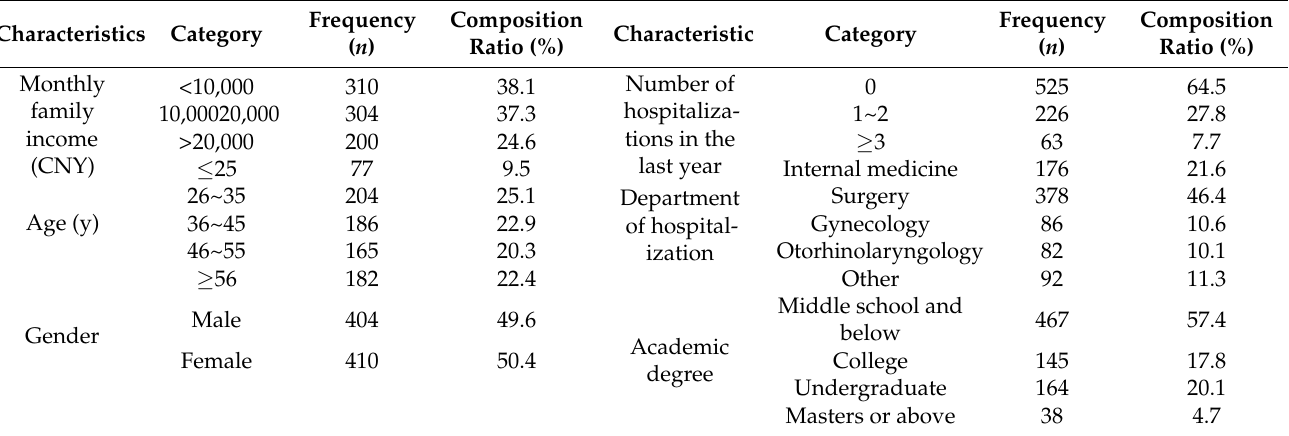
Table 3. Descriptive statistics of the sample ( n =